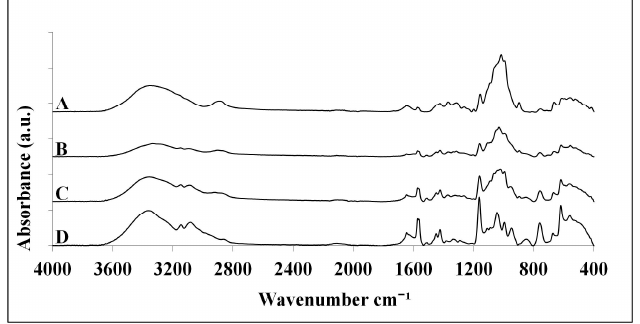
Figure 2. Full length ATR-FTIR spectra as a function of lignin content: (A) 100% cellulose film; (B) 17% lignin film; (C) 27.5% lignin film; and (D) 38% Lignin Film.